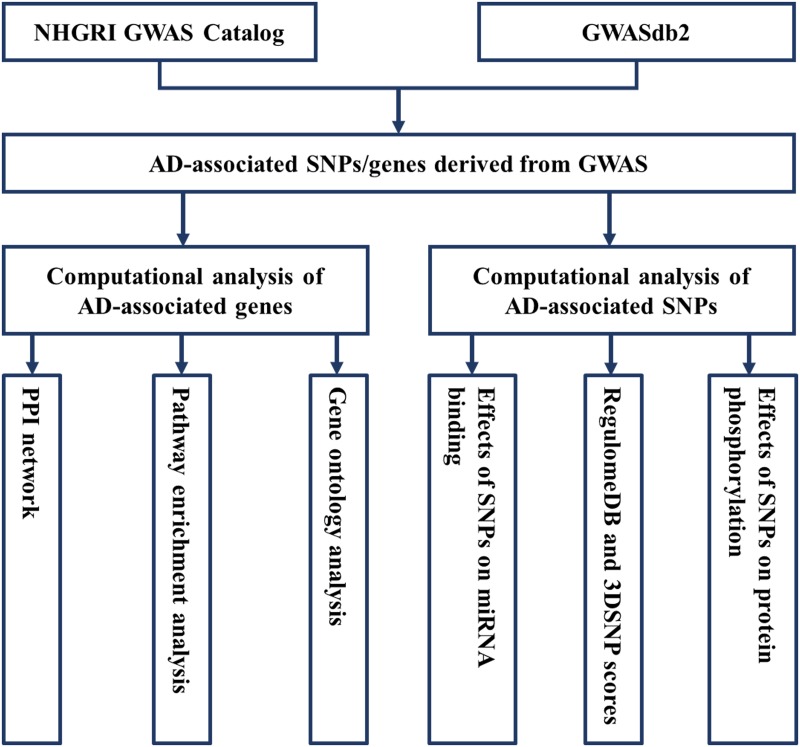
Workflow for Alzheimer’s disease -associated loci derived from genome-wide association studies.